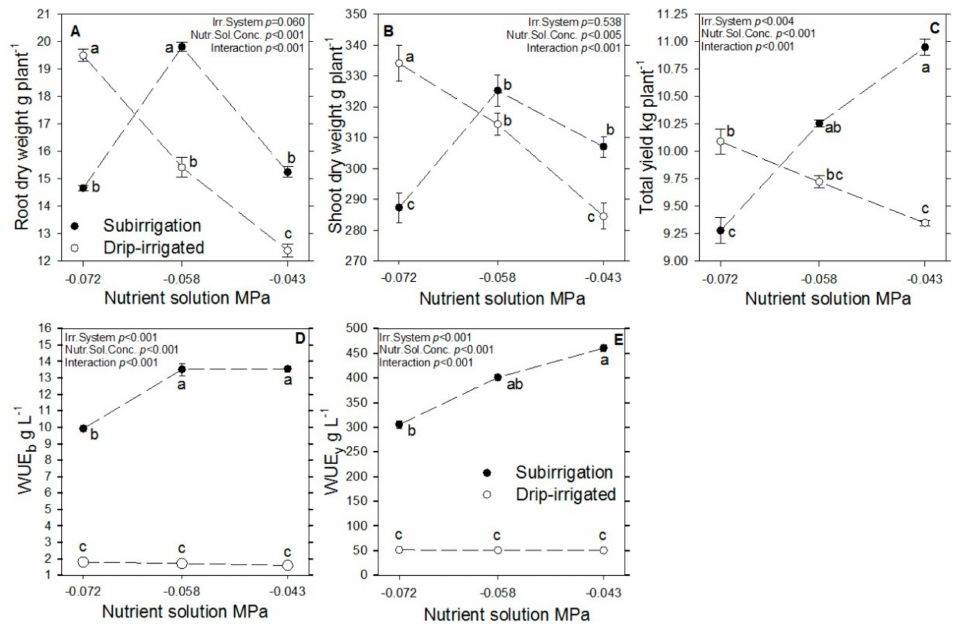
Figure 1. ( A – E ) Growth, yield, and water use e ffi ciency in terms of biomass (WUE b ) and fruit yield (WUE y ) in subirrigated and drip-irrigated tomato ( Solanum lycopersicum L.) plants with solutions of varying nutrient concentration. ANOVA significance for both factors, irrigation system (Irr. System) and nutrient solution concentration (Nutr. Sol. Conc.), and the interaction is shown. Means with the same lower-case letter indicate non-significant di ff erences according to Tukey’s multiple comparison test. Bars represent the standard error of the mean ( n = 4).